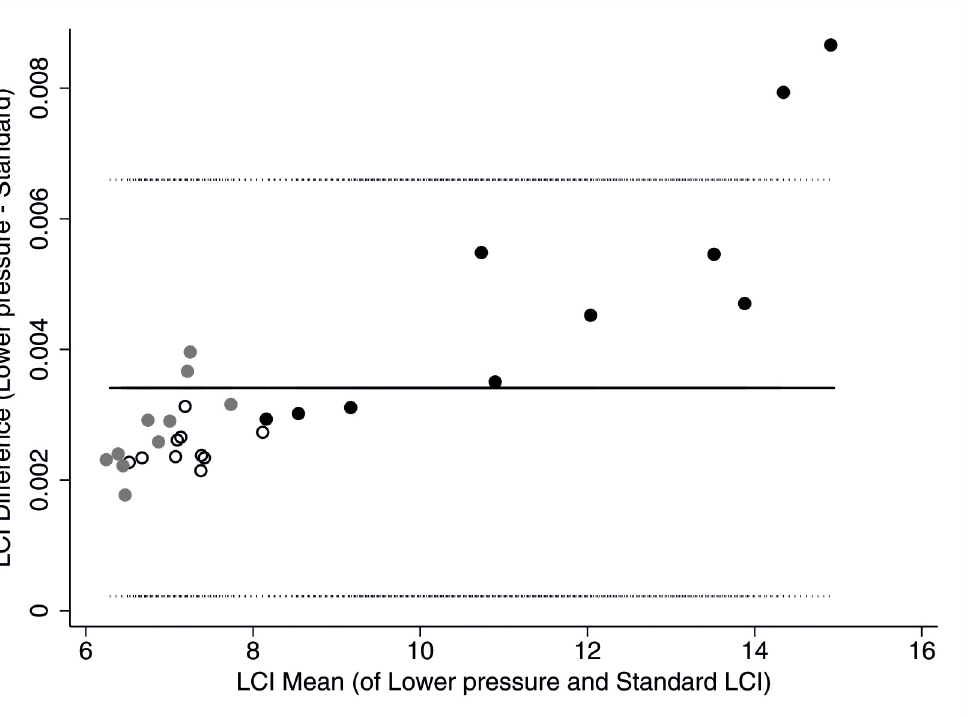
Fig 2. LCI measurement bias due to decreased ambient pressure settings. Bland Altmann plot of lung clearence index (LCI) determined at lower ambient pressure setting (960 kPa instead of 980 kPa) minus baseline LCI versus mean of both LCI. Black circles represent children with CF, grey circles former preterm and open circles healthy children. Solid line represent mean difference (0.0034), dotted lines represent upper (0.0066) and lower (0.0002) limits of agreement.